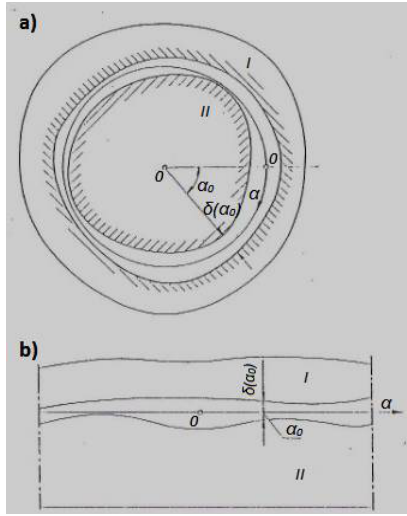
Figure 1. The cross section of Stator I and Rotor II cores: ( a ) cylindrical layout; ( b ) equivalent flat layout.